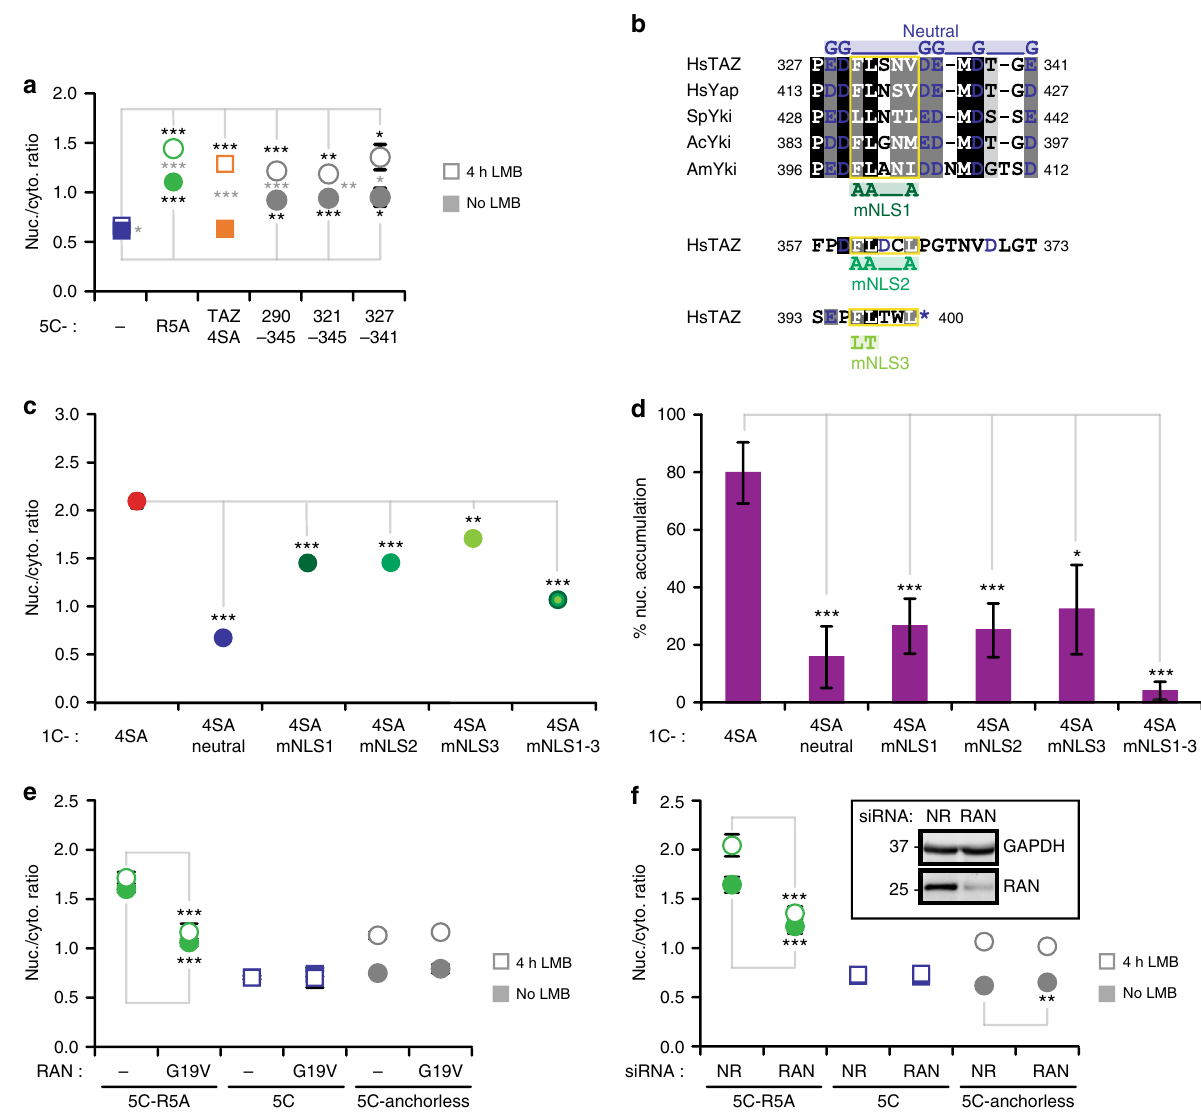
Fig. 5 Characterization of the TAZ-NLS and its mediated import. a Median R N/C values of control (5C), 5C-R5A, 5C-TAZ 4SA, and 5C-tagged TAZ fragments. Gray asterisks indicate statistically signi fi cant changes upon LMB treatment. Black asterisks mark signi fi cant differences relative to the control (5C), n = 3. b Sequence alignment of region 327 – 341 in human (Hs) TAZ with human Yap and orthologs (Yorkie, Yki) from sea slug (Ac: Aplysia californica), bee (Am: Apis mellifera), and sea urchin (Sp: Strongylocentrotus purpuratus). Positions with identical residues and conserved physicochemical properties are shown on black and dark gray background, respectively. Light gray indicates 80% conservation of properties. Negatively charged residues are depicted in blue. The central hydrophobic motif FLxx[I,V,L,M] is marked by a yellow box. Substitutions of the “ neutral ” mutant are shown above the alignment, mutation of the hydrophobic motif mNLS1 below. Related sequences in TAZ and mutations mNLS2 and mNLS3 are shown below. The blue star indicates the C-terminus. c Median R N/C values of indicated 1C-TAZ constructs, n = 3. d Nuclear enrichment of indicated 1C-TAZ constructs, n = 3 or 6 for individual constructs. e Constitutively active RAN G19V inhibits classic NLS-mediated nuclear import but not that of anchorless TAZ. Median R N/C values of 5C-R5A, the 5C-tag alone, and 5C-anchorless (TAZ 4SA F52A), when co-expressed with control vector or RAN G19V, in the absence and presence of 4 h LMB treatment, n = 4. f siRNA-induced silencing of RAN does not affect nuclear import of anchorless TAZ. Median R N/C values of 5C-R5A, the 5C-tag alone, and 5C-anchorless (TAZ 4SA F52A), when co-transfected with non-related (NR) or RAN-speci fi c siRNA, in the absence and presence of 4h LMB treatment, n = 4. Insert: western blot showing the ef fi ciency of RAN-silencing with GAPDH as loading control. An uncropped version is shown in Supplementary Figure 1B. Data are represented as means ± SD. * p < 0.05, ** p < 0.01, *** p < 0.001; Student ’ s t “ retention ” of TAZ. In the following experiments we wished to (Fig. 7b). LMB treatment abolished the differences between the dissect the structural features responsible for these opposite various constructs, indicating that their initial differential dis- functions. tribution was not due to their inability to translocate into the nucleus. Intriguingly, when TEAD1 was co-expressed, 1C-TBD relocated to the nucleus (Fig. 7c). Thus, paradoxically, the TBD The TBD comprises a CRM1-dependent NES . Sequence align- appears to have two opposite functions: it can promote cyto- ment highlighted a conserved pattern of hydrophobic residues in plasmic localization, as well as TEAD-dependent nuclear the TEAD-binding site vaguely reminiscent of a CRM1-